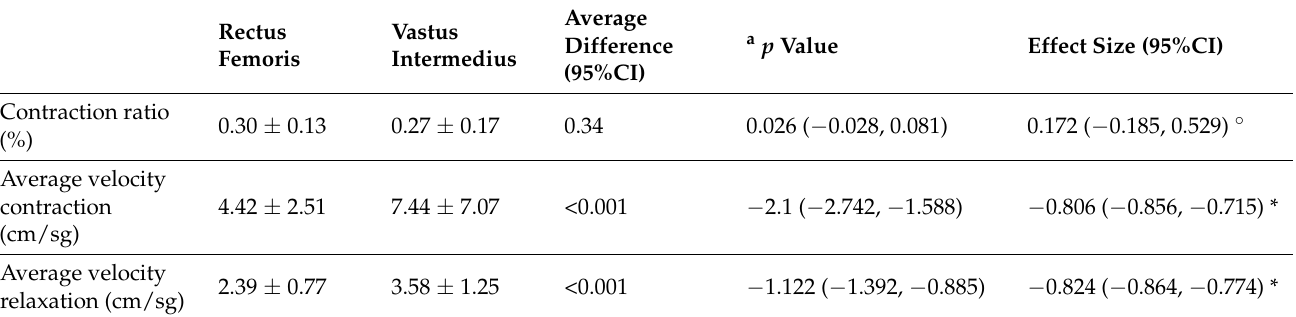
Table 2. Ratio and velocities of rectus femoris contraction vs. vastus